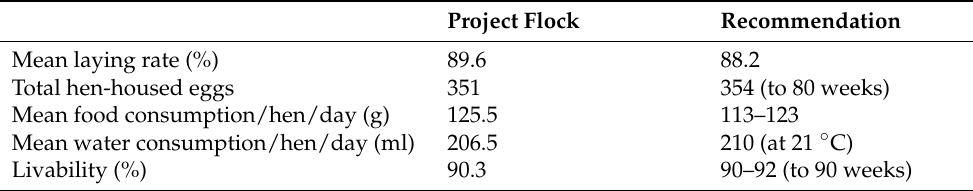
Table 3. Production data (weeks of life 22–78) of the project flock and breeder’s recommendations [30]. Table 3 . Production data (weeks of life 22 – 78) of the project flock and breeder ’s recommendations [30].